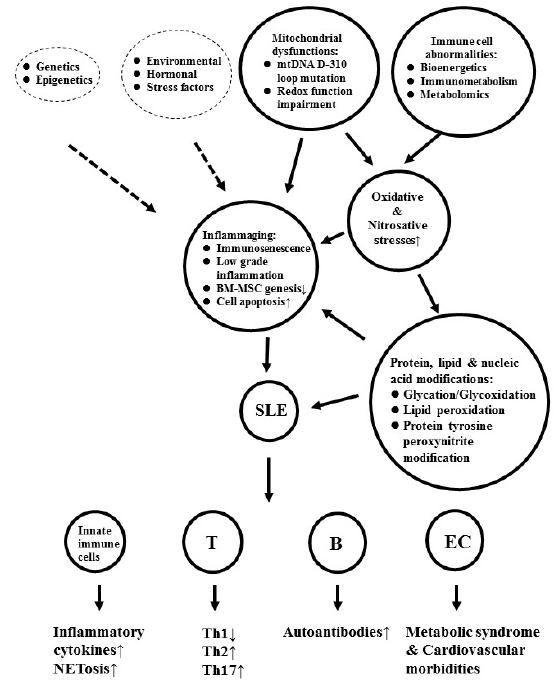
Figure 1. The factors that contribute to inflammaging and metabolic syndrome in patients with SLE. The broken circles are not discussed in the present review. mt: Mitochondrial; Redox: Reduction and oxidation; BM-MSC: Bone marrow derived mesenchymal stem cell; T: T lymphocyte; B: B lymphocyte; EC: Endothelial cell; Th: Helper T cell; NETosis: Apoptosis of neutrophil to form neutrophil extracellular trap.